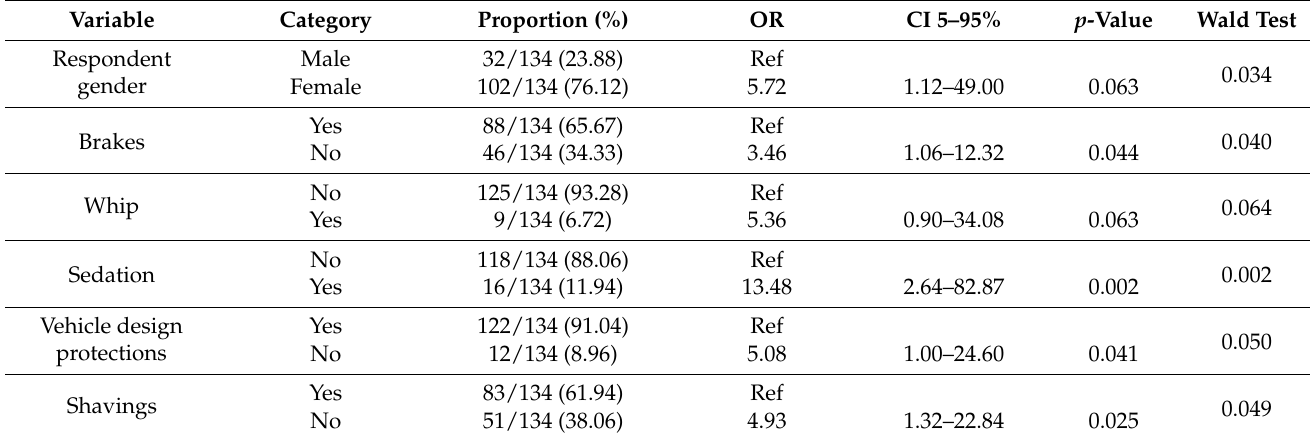
Table 8. Results of the stepwise multivariable logistic regression analysis with the variables associated with transport-related problem behaviors (TRPBs) reported in the replies ( n = 148) to a survey on horse road transport in Italy. Results are expressed as the odds ratio (OR), confidence interval (95% CI), p -value for each predictive variable and total p value of the Wald test.